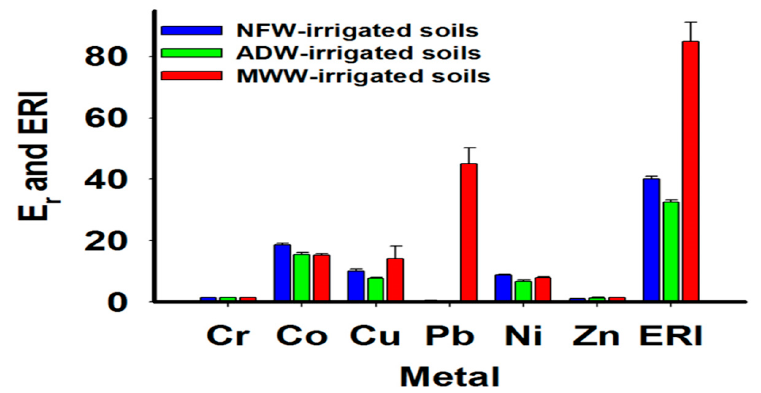
Figure 3. Single ecological risk (E r ) and poetical ecological risk index (ERI).